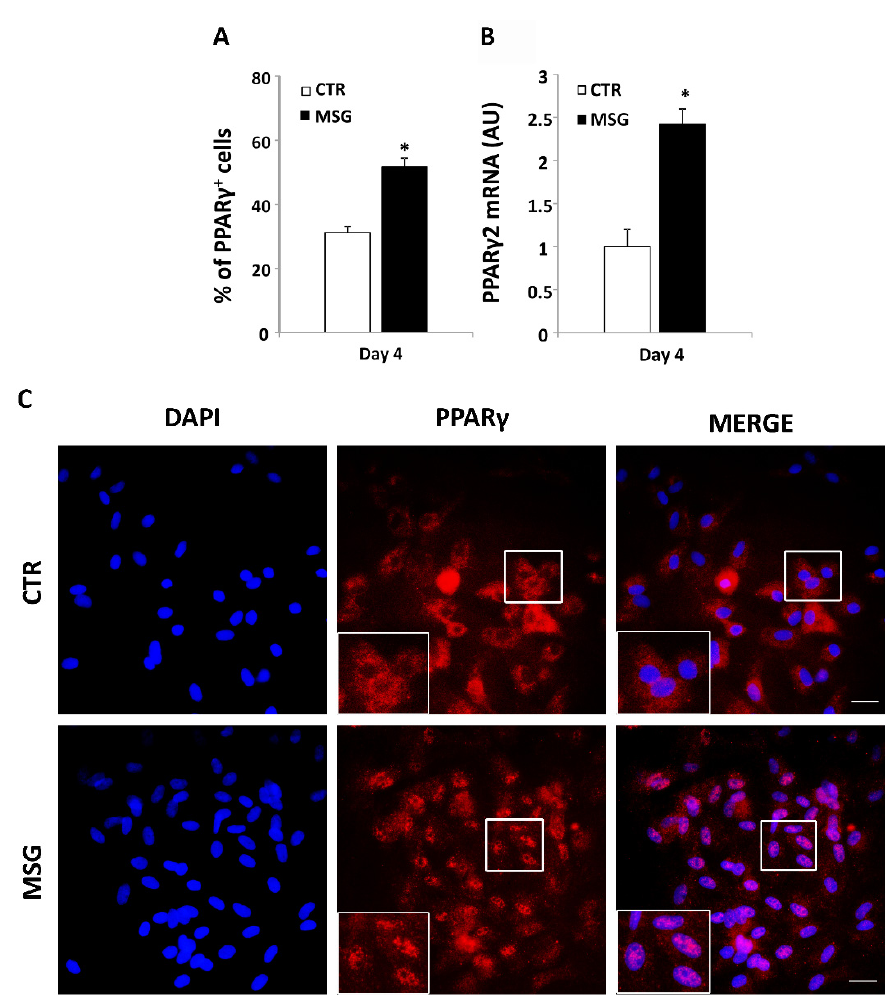
Figure 2. MSG cells display higher expression of Peroxisome proliferator ‐ activated receptor (PPAR) γ 2 during in vitro differentiation. ( A ) Percentage of PPAR γ positive cells related to the total cell number counted by nucleus 4 ′ ,6 ‐ diamidino ‐ 2 ‐ phenylindole (DAPI) staining; ( B ) mRNA cell expression levels of PPAR γ 2 in CTR and MSG stromal vascular fraction (SVF) cells on Differentiation Day (Dd) 4 (AU: arbitrary units). Values are the means ± SEM ( n = 5/6 different experiments). * p < 0.05 vs. CTR values; ( C ) Representative images of DAPI nucleus staining (blue), PPAR γ positive cells (red) and merged image of CTR and MSG cells on Dd 4 (40× magnification, scale bar at 20 μ m). The insert shows cytoplasmatic or nuclear PPAR γ localization.